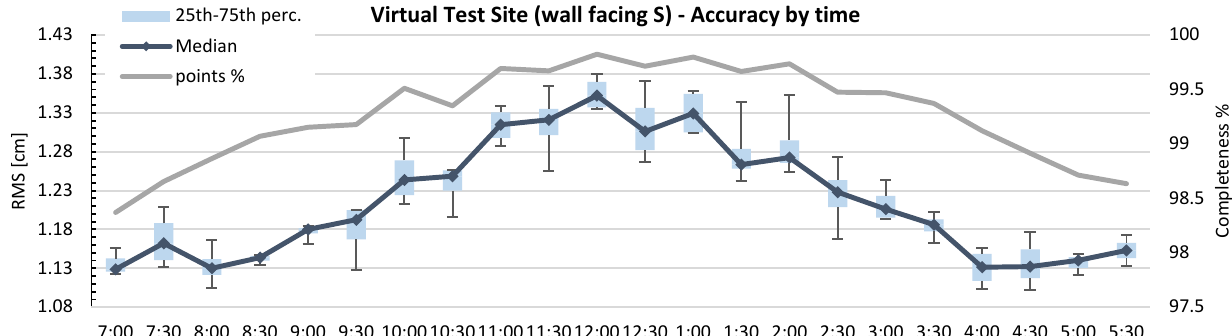
Figure 3. RMS and completeness variability for the virtual test site